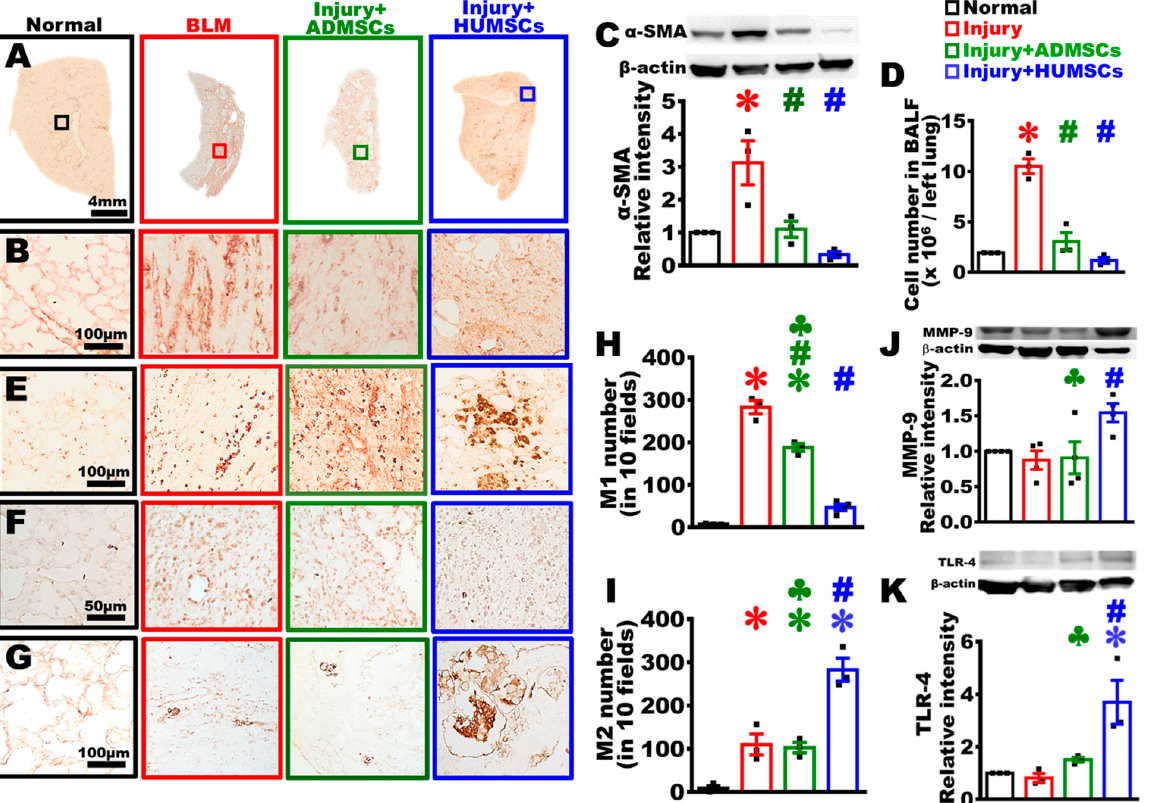
Figure 5. Transplantation of HUMSCs, but not ADMSCs, stimulated MMP-9 synthesis and TLR-4 expression in PF rats. Lower-magnification ( A ) and higher-magnification ( B ) immunohistochemical photographs of left lung sections from each group were stained with anti- α -SMA antibody to detect activated myofibroblasts on Day 49. The amount of α -SMA in the left lung was measured using a Western blot, and it revealed that the Injury+ADMSCs and Injury+HUMSCs groups had much less activated myofibroblasts than the Injury group did. On Day 49 ( C ). The cell count of bronchoalveolar lavage remained greater in the Injury group than those in the Injury+ADMSCs and Injury+HUMSCs groups ( D ). On Day 49, immunohistochemical photographs of left lung sections from each group were stained with anti-ED1 ( E ), anti-CD86 ( F ), and anti-CD163 antibodies ( G ) to label macrophage, M1 macrophage, and M2 macrophage, respectively. Quantification results showed that an increase in M1 macrophages in the Injury and the Injury+ADMSCs groups ( H ). Moreover, a robust increase in M2 macrophages in the Injury+HUMSCs group ( I ). Measurement of the amount of MMP-9 ( J ) and TLR-4 ( K ) expression in the left lung using Western blotting revealed that HUMSCs transplantation increased MMP-9 and TLR-4 expression. n = 6~8 in each group for immunostaining, n = 3~4 in each group for Western blotting.